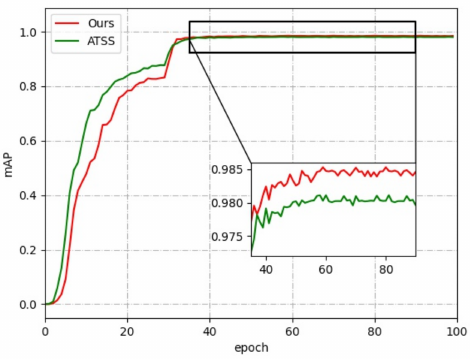
Figure 13. mAP curves of two matching strategies on multi-scene electronic component